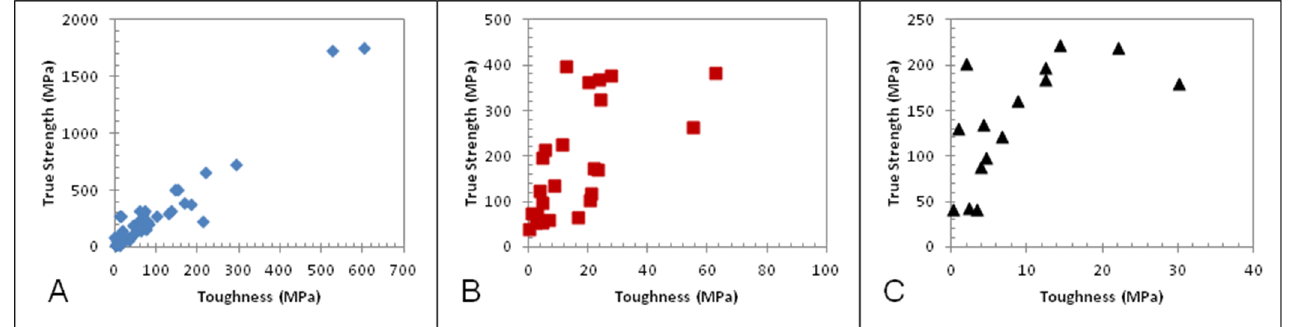
Figure 4. Correlation of strength and toughness for ( A ) as-spun PAN composite nanofibers (with succinite and SiO 2 nanopowder) and composite nanofibers annealed at ( B ) 130 °C and ( C ) 180 °C.